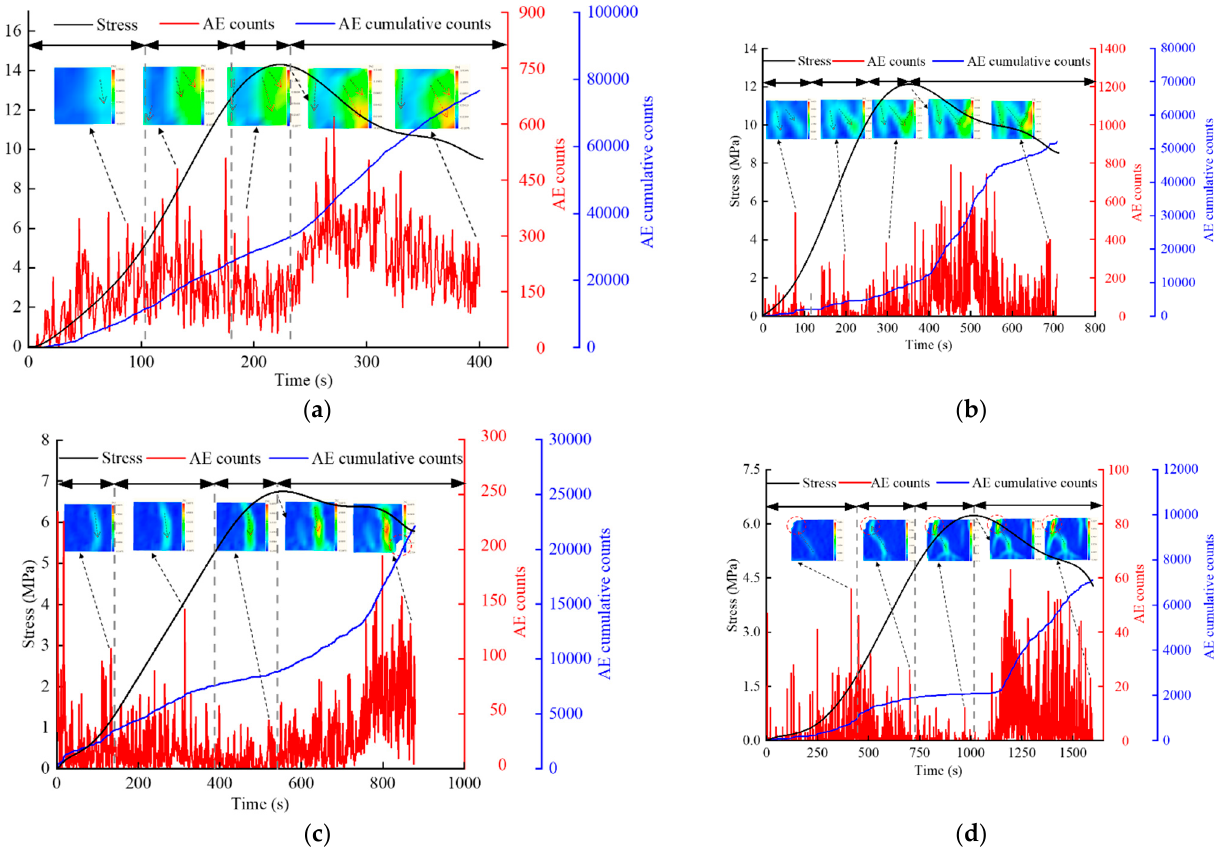
Figure 8. Crack propagation and evolution process and corresponding AE time series response of backfills of different sizes: ( a ) 40 mm × 40 mm × 40 mm; ( b ) 70.7 mm × 70.7 mm × 70.7 mm; ( c ) 100 mm × 100 mm × 100 mm; ( d ) 150 mm × 150 mm × 150 mm.